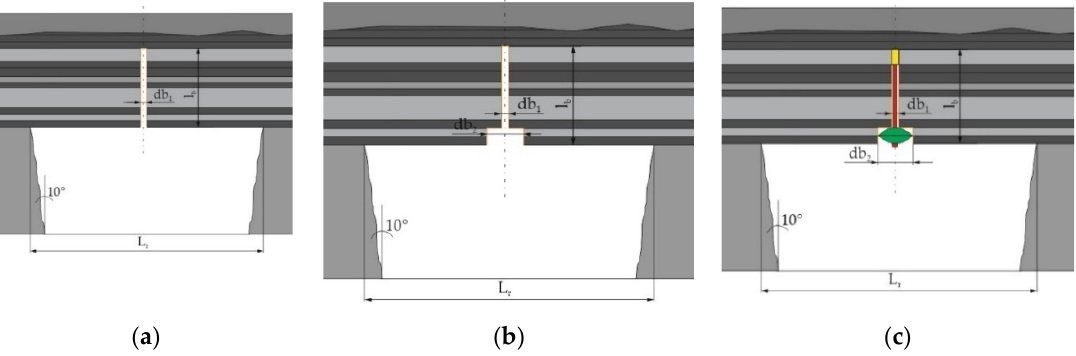
Figure 17. Stages of installing a mechanical bolt support with a sleeve head, equipped with dome bearing plates: ( a ) drilling the entire bolt hole (diameter 25.4 mm); ( b ) widening the bolt hole at the roof by a length equal to the height of the dome bearing plates; ( c ) installing and pre-tensioning; Lr—room width; db 1 —diameter of the bolt hole; db 2 —diameter of the widened bolt hole; l b —length of bolt hole.